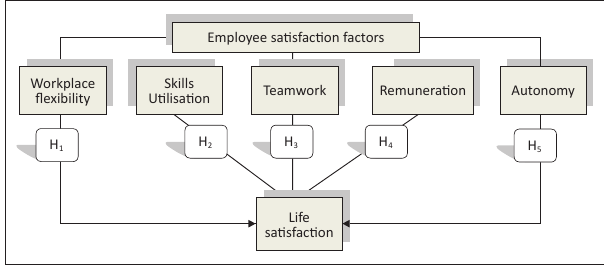
FIGURE 1: Conceptual framework for employee satisfaction and life satisfaction . The framework depicts that workplace flexibility, skills utilisation, teamwork, remuneration and autonomy are employee satisfaction dimensions, all of which are positively related to life satisfaction.